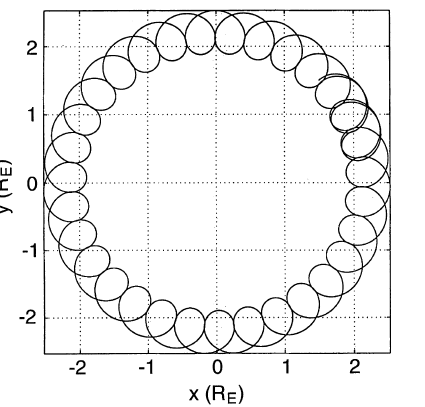
Fig. 1. Planar equatorial trajectory of a proton (1 GeV) in a zonal dipole magnetic field ( m (cid:136) 0, n (cid:136) 1; g 10 (cid:136) ) 29775 nT)